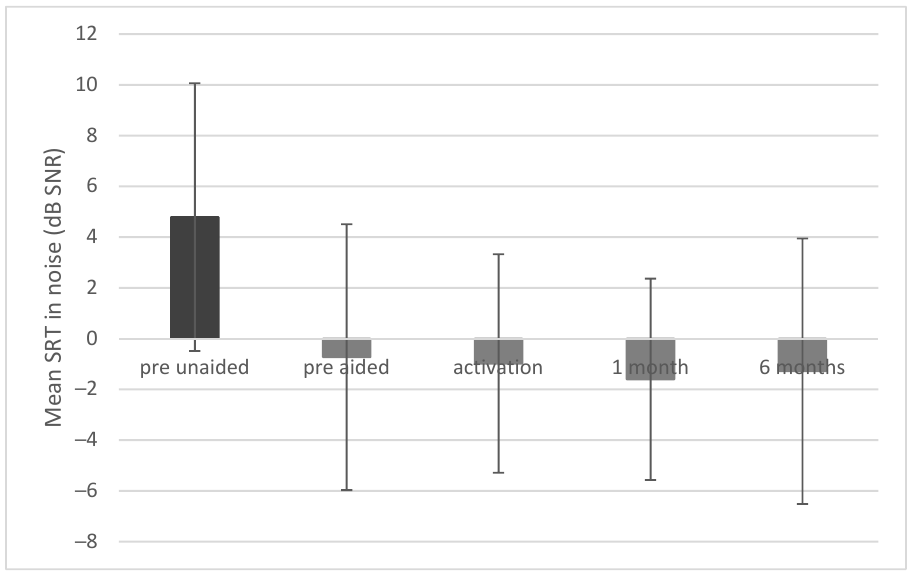
Figure 8. Speech reception thresholds (SRTs) in noise. All differences between pre-unaided and all other conditions are statistically significant at p < 0.001. The bars represent mean scores, the error bars are standard deviations.